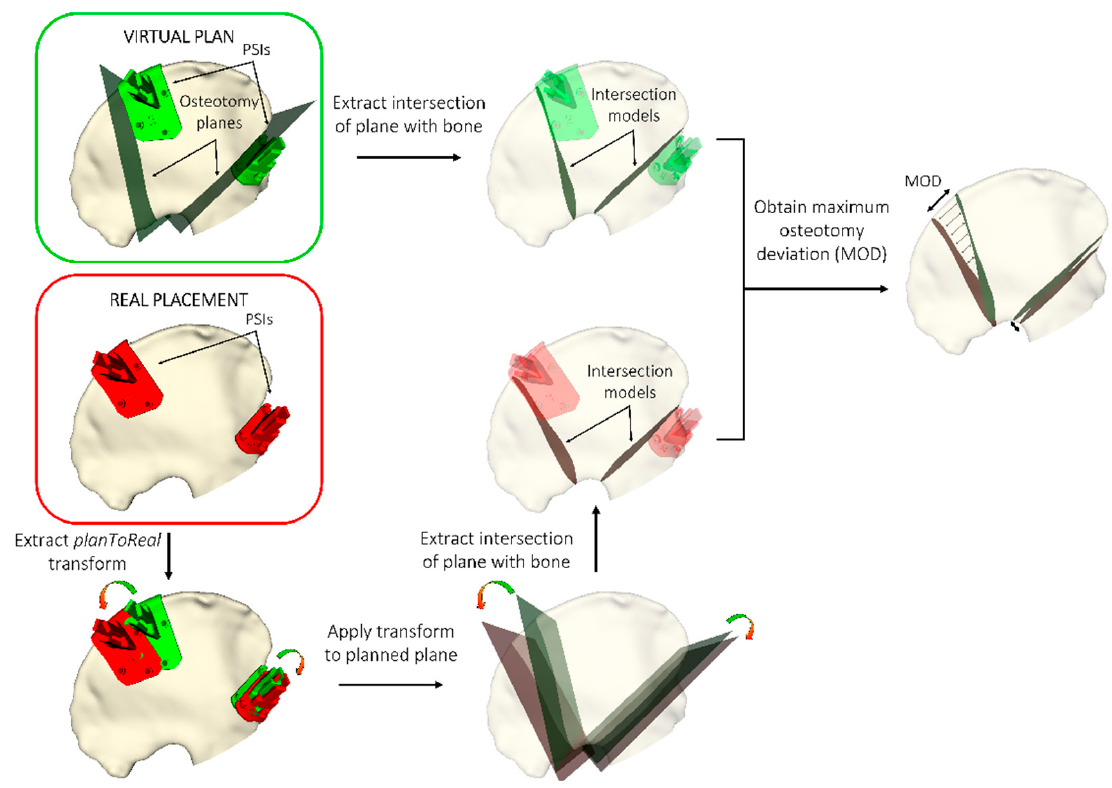
Figure 5. Computation of the maximum osteotomy deviation (MOD) between planned and real osteotomy planes. The real osteotomy is defined by the PSI placement performed by the user.